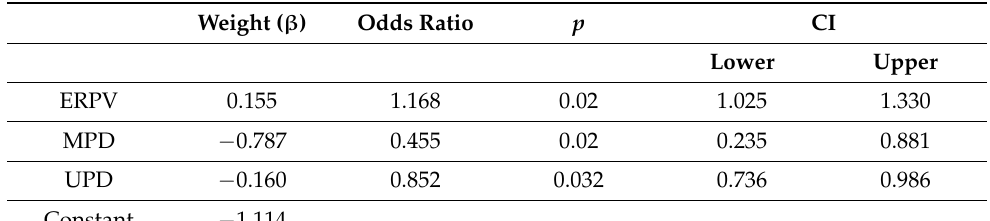
Table 3. Multivariate logistic regression for Model 1.